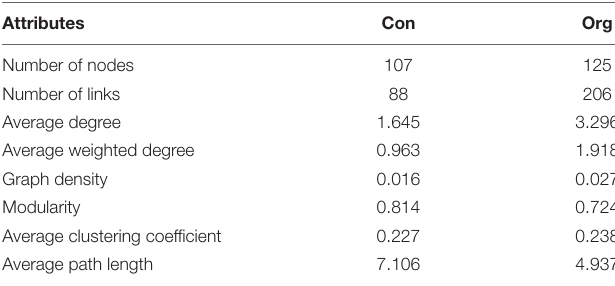
TABLE 1 | The network attributes of AM fungal community composition on conventional (Con) and organic (Org) maize fields. Attributes Con